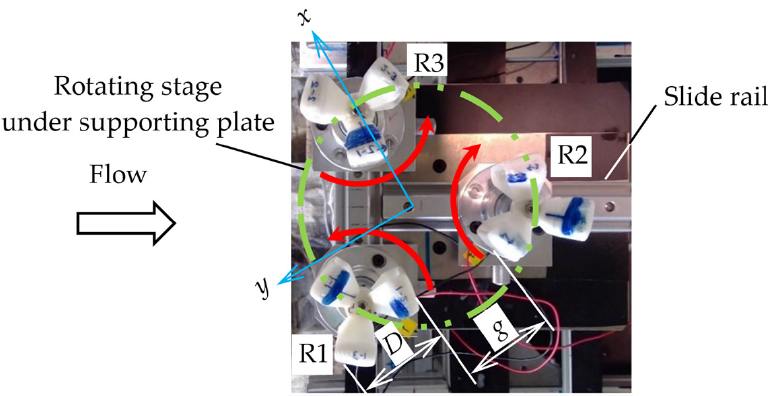
Figure 9. Experimental setup of a trio of 3D-printed VAWT models with a gap of g / D = 1 in the 3IR configuration at θ = 120° (2COB).